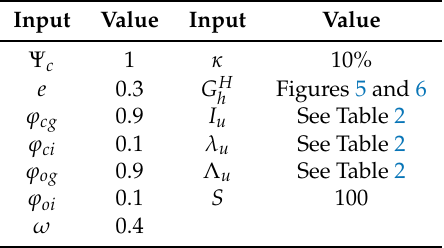
Table 3. Values of the input parameters for the